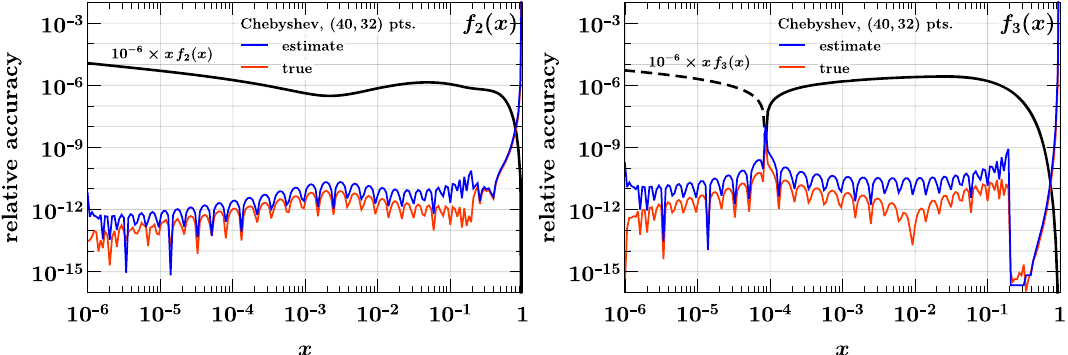
Fig. 7 Comparison of the true relative interpolation accuracy (red) and its estimate (blue) obtained from the difference between interpolation on the Chebyshev grid with and without its end points. The ( 40 , 32 ) -point grid used is the same as in Fig.